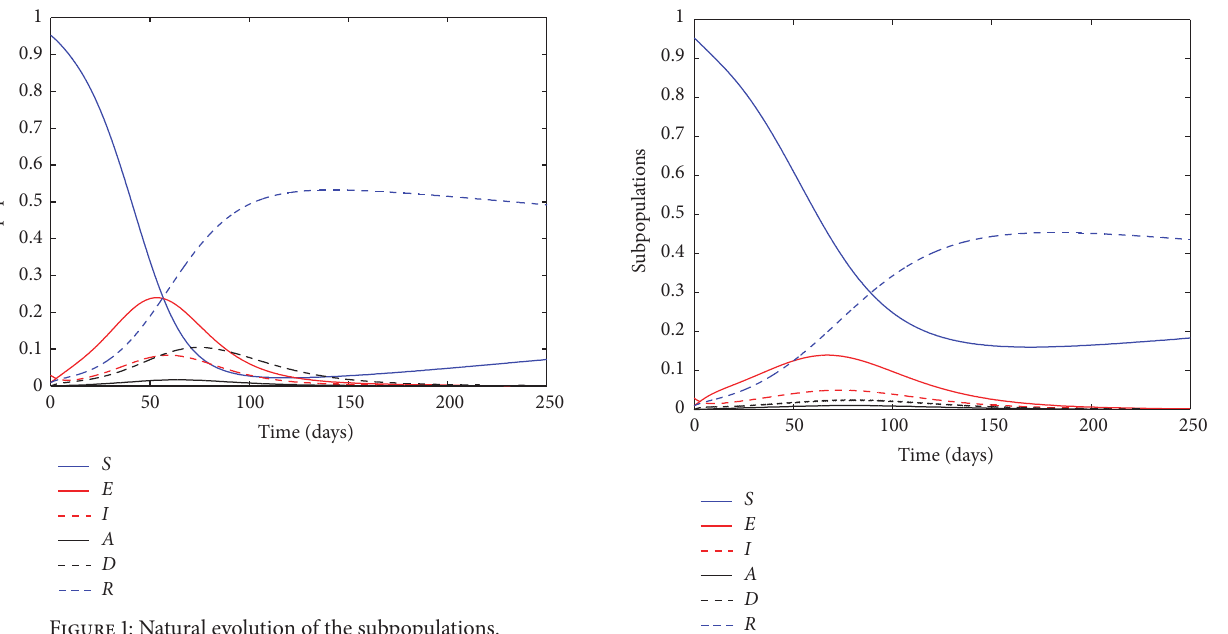
Figure 3: Evolution of the subpopulations with a daily culling rate of 𝜌 𝐷 = 0.1 .